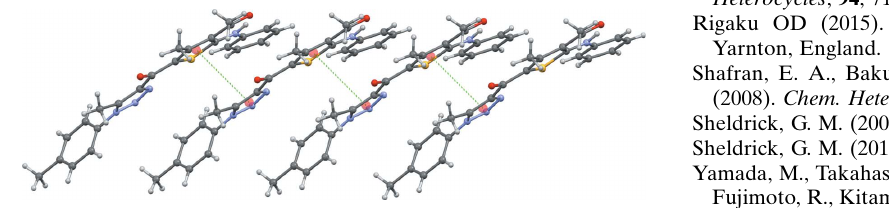
Figure 3 A segment of the crystal structure showing (cid:2) – (cid:2) contacts within a stack.